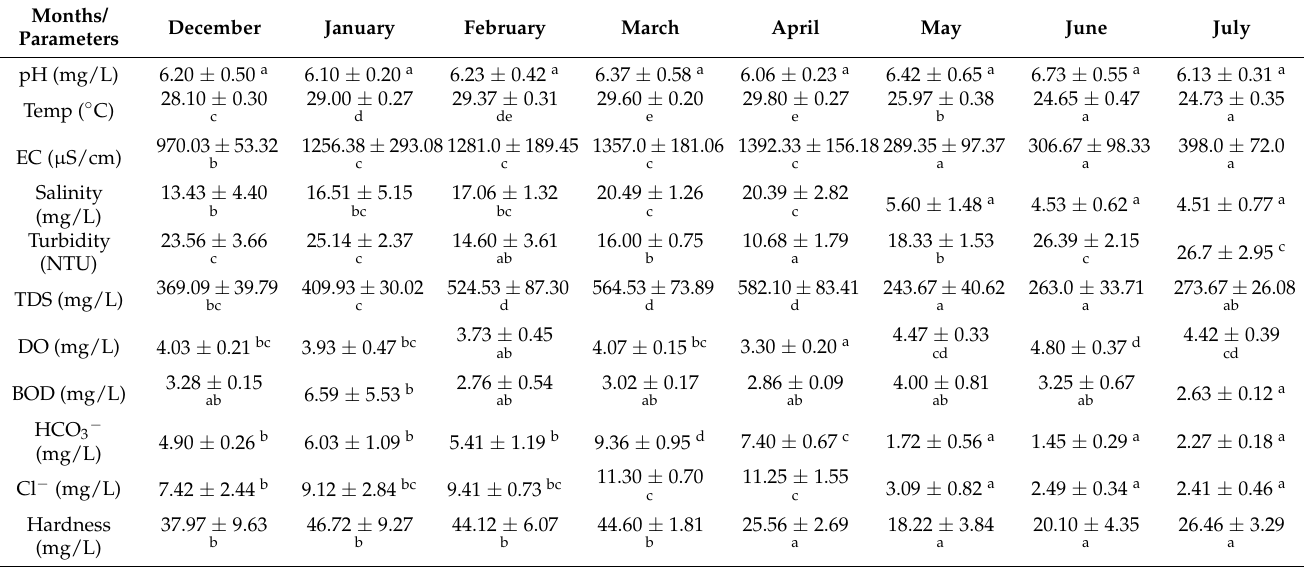
Table 1. Summary of mean physicochemical properties of surface water parameters of Ogbor